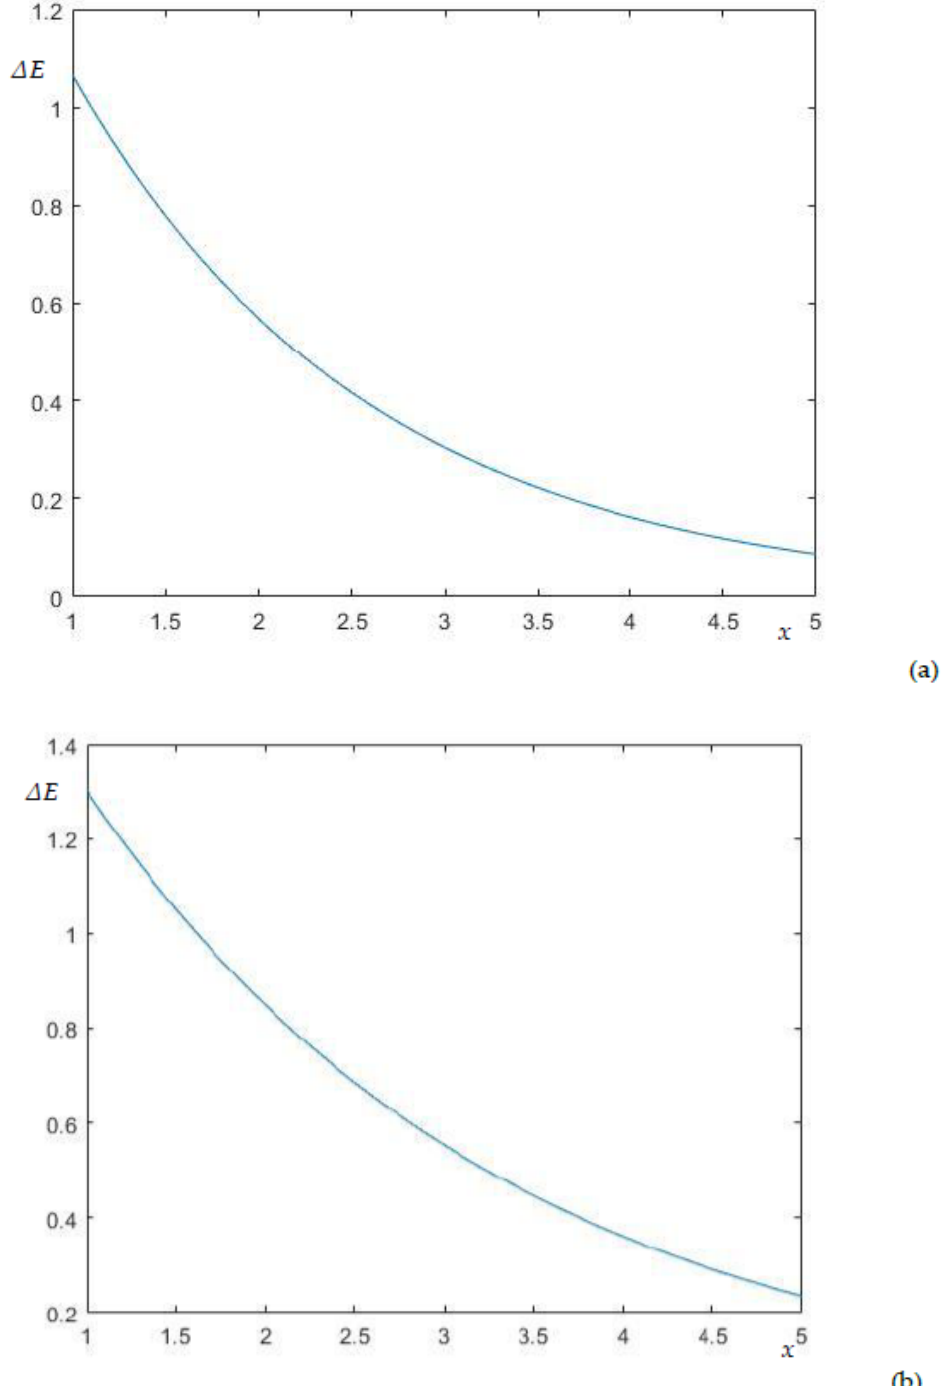
Figure 7. Graph of the equation of the II state in the inactivated state with different parameters ( a , b ). The II goes beyond the boundaries of the human mind/potential pit. The Y axis represents the change in potential energy/activity ( ∆ E ) of the II, the X axis is x— a conditional coordinate in the space of information images.